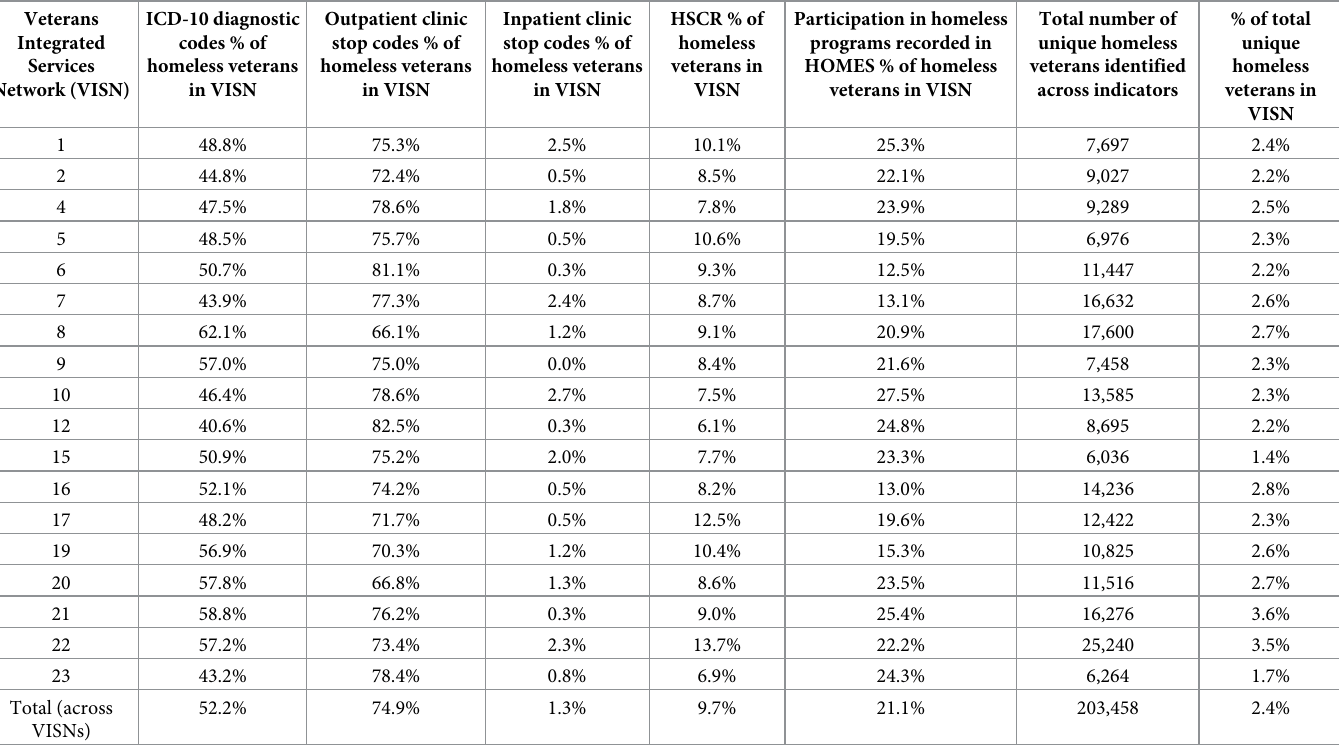
Table 3. Geographic variability in use of different indicators of